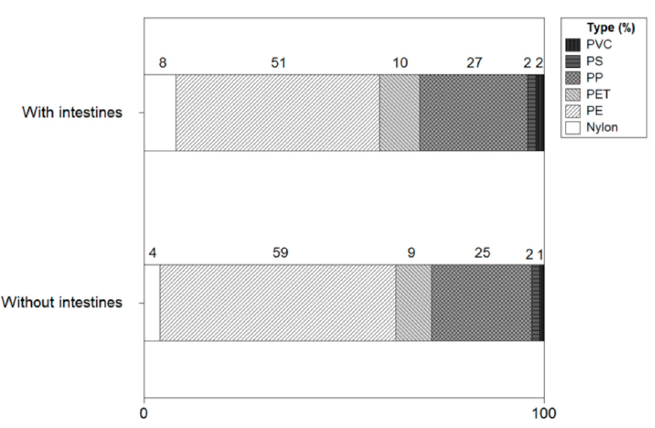
Figure 13. Types of microplastics with and without intestines and heads of shrimp.